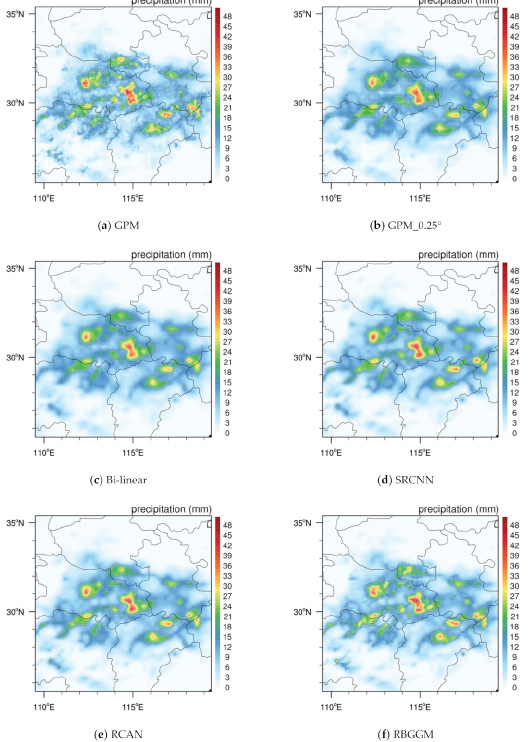
Figure 10. Heavy precipitation distribution GPM precipitation: ( a ) original GPM precipitation; and ( b ) GPM 0.25 ◦ ; as well as precipitation downscaling results: ( c ) bi-linear; ( d ) SRCNN; ( e ) RCAN; and ( f )